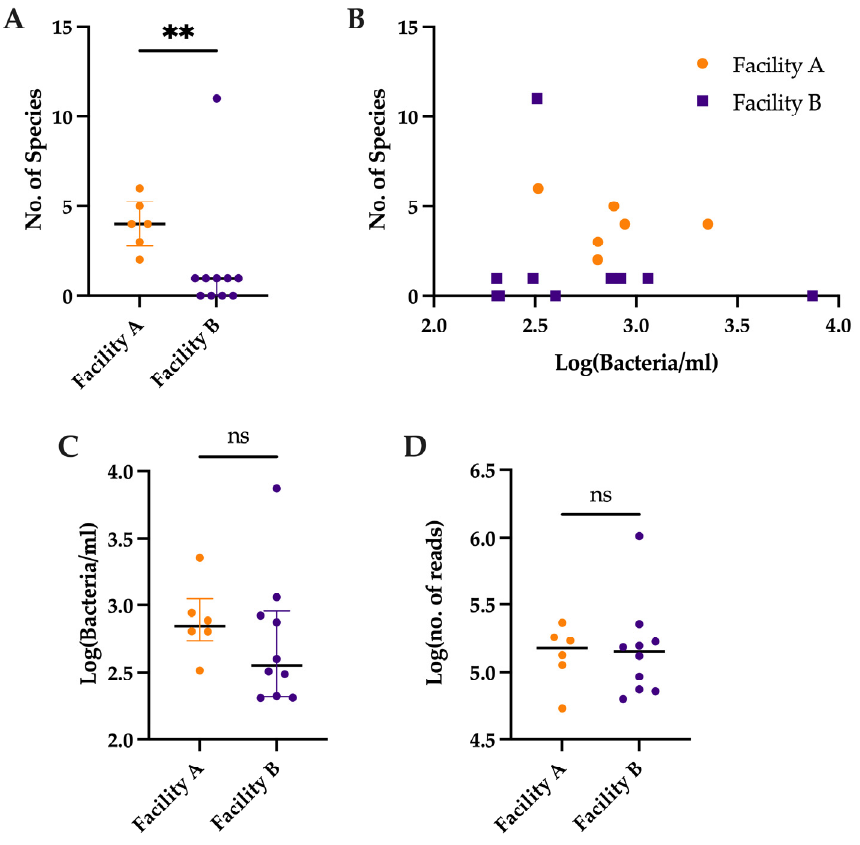
Figure 3. ( A ) Comparison of number of species detected (minus those present in negative control) in sequences from each facility (Median ± IQR). ( B ) Non-significant relationship between Log(Bacteria/mL) and No. of Species detected (minus those present in negative control). ( C ) Comparison of Log(Bacteria/mL) of samples sent to each of Facility A and Facility B. ( D ) Comparison of Log(no. of reads) produced for each sample following quality control. ns p > 0.05, ** p < 0.01